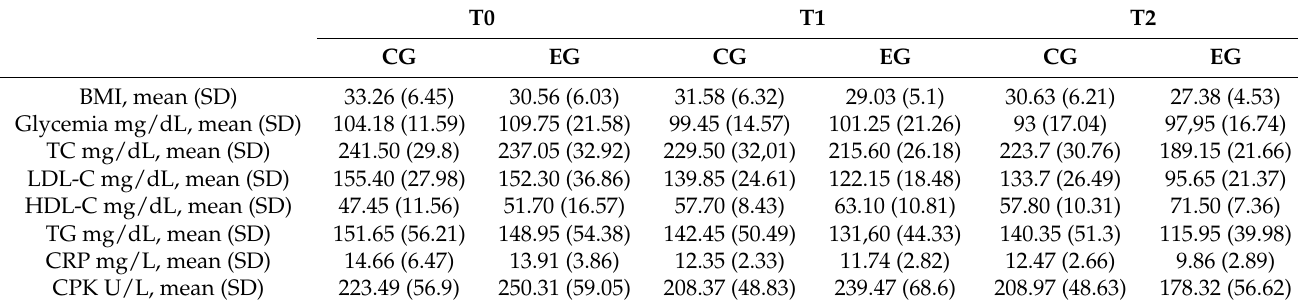
Table 1. Descriptive characteristics for each time for EG and CG.